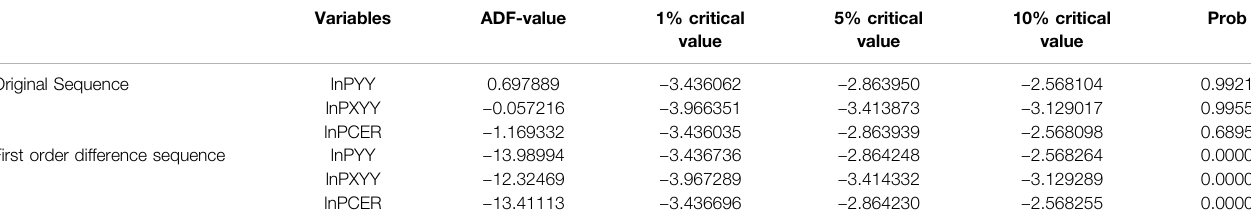
TABLE 1 | Stationary test results.